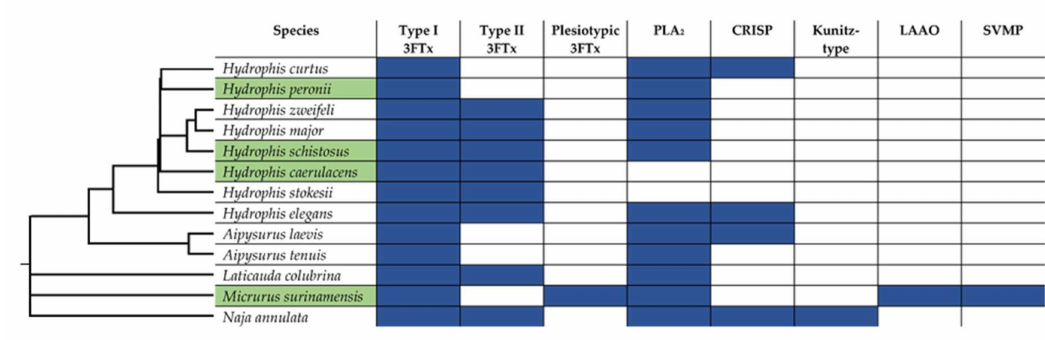
Figure 3. LC-MS / MS results highlighted by their toxin class representative matches from ProteinPilot ™ v. 5.0. Toxin family abbreviations are as follows: Type I 3FTx, short-chain three-finger toxin; Type II 3FTx, long-chain three finger toxin; Plesiotypic 3FTx, plesiotypic three-finger toxin; PLA2, phospholipase A 2 ; CRISP, cysteine-rich secretory peptide; Kunitz-type; kunitz-type protease inhibitor; LAAO, L-amino acid oxidase; SVMP, snake venom metalloprotease. Blue rectangles indicate the toxin type was matched from the LC-MS / MS results. Species names highlighted in green were species that did not bind orthosterically to postsynaptic nAChR mimotopes (Figure 1). Phylogeny was taken from Timetree.org and adjusted using recent phylogenetic data [4]. All LC-MS / MS raw data output from ProteinPilot ™ v. 5.0 can be found in Supplementary File